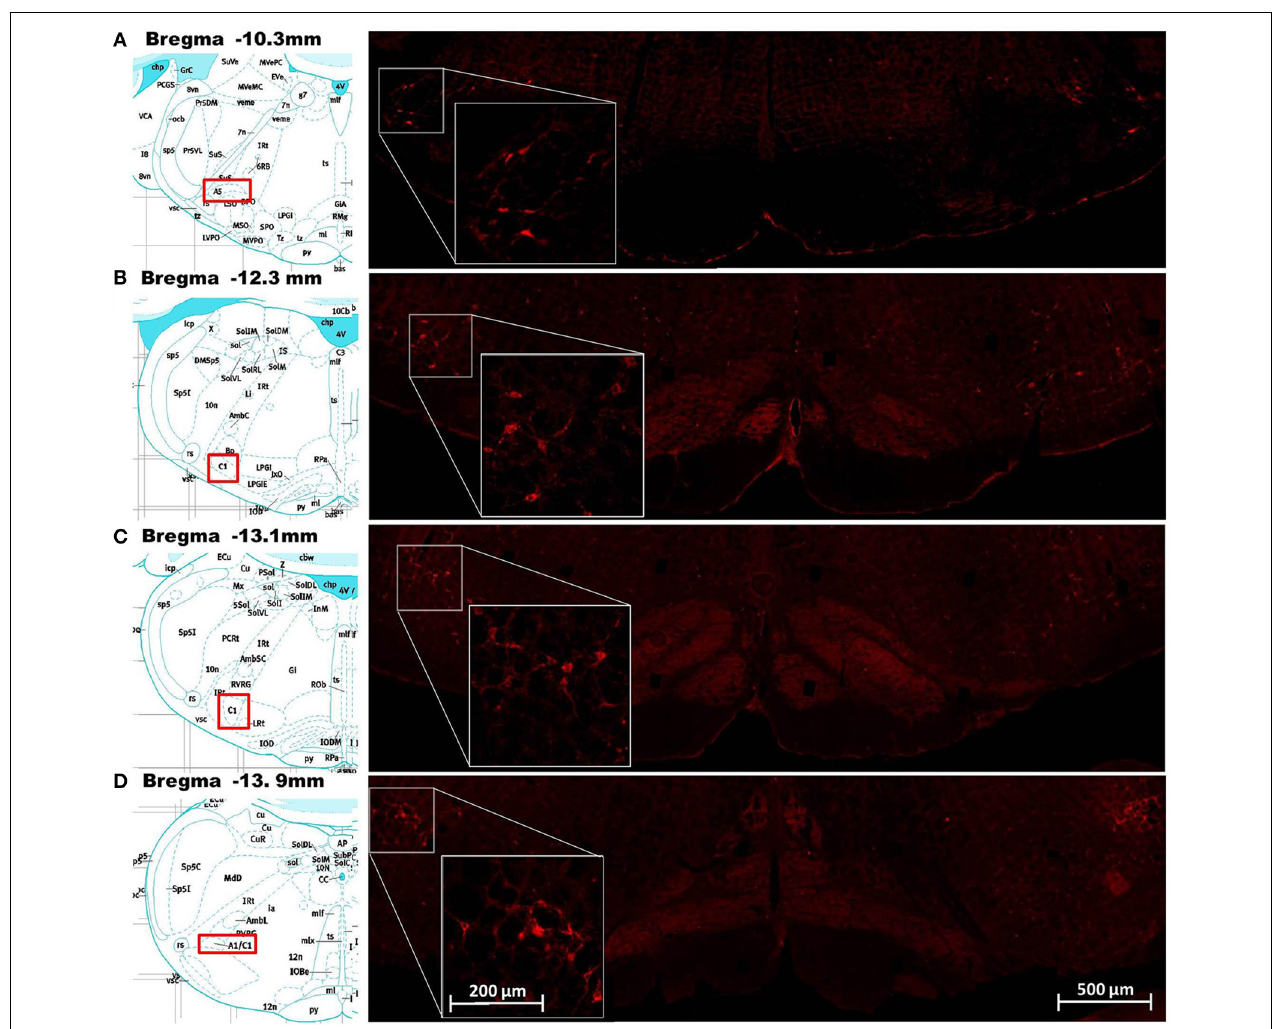
FIGURE 1 | Demonstration of leptin receptor (ObRb) positive cells at various points along the rostrocaudal axis of the ventral hindbrain. Images in the right column show corresponding histological staining for ObRb (red labeled cells) in the ventral hindbrain at the level of the A5 cell group (A) , RVLM (B) , C1 cell group (C) , and A1 cell group (D) .